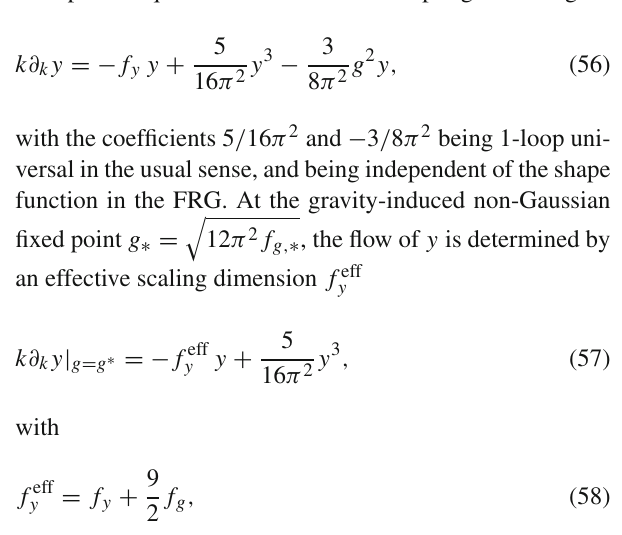
Fig. 4 Left panel: We show f y , ∗ , corresponding to the critical exponent at the free fixed point in standard gravity for the exponential (red, dashed line) and Litim-type (blue continuous line) cutoff. Right panel: We show f y , ∗ , corresponding to the critical exponent at the free fixed point in unimodular gravity for the two cutoffs